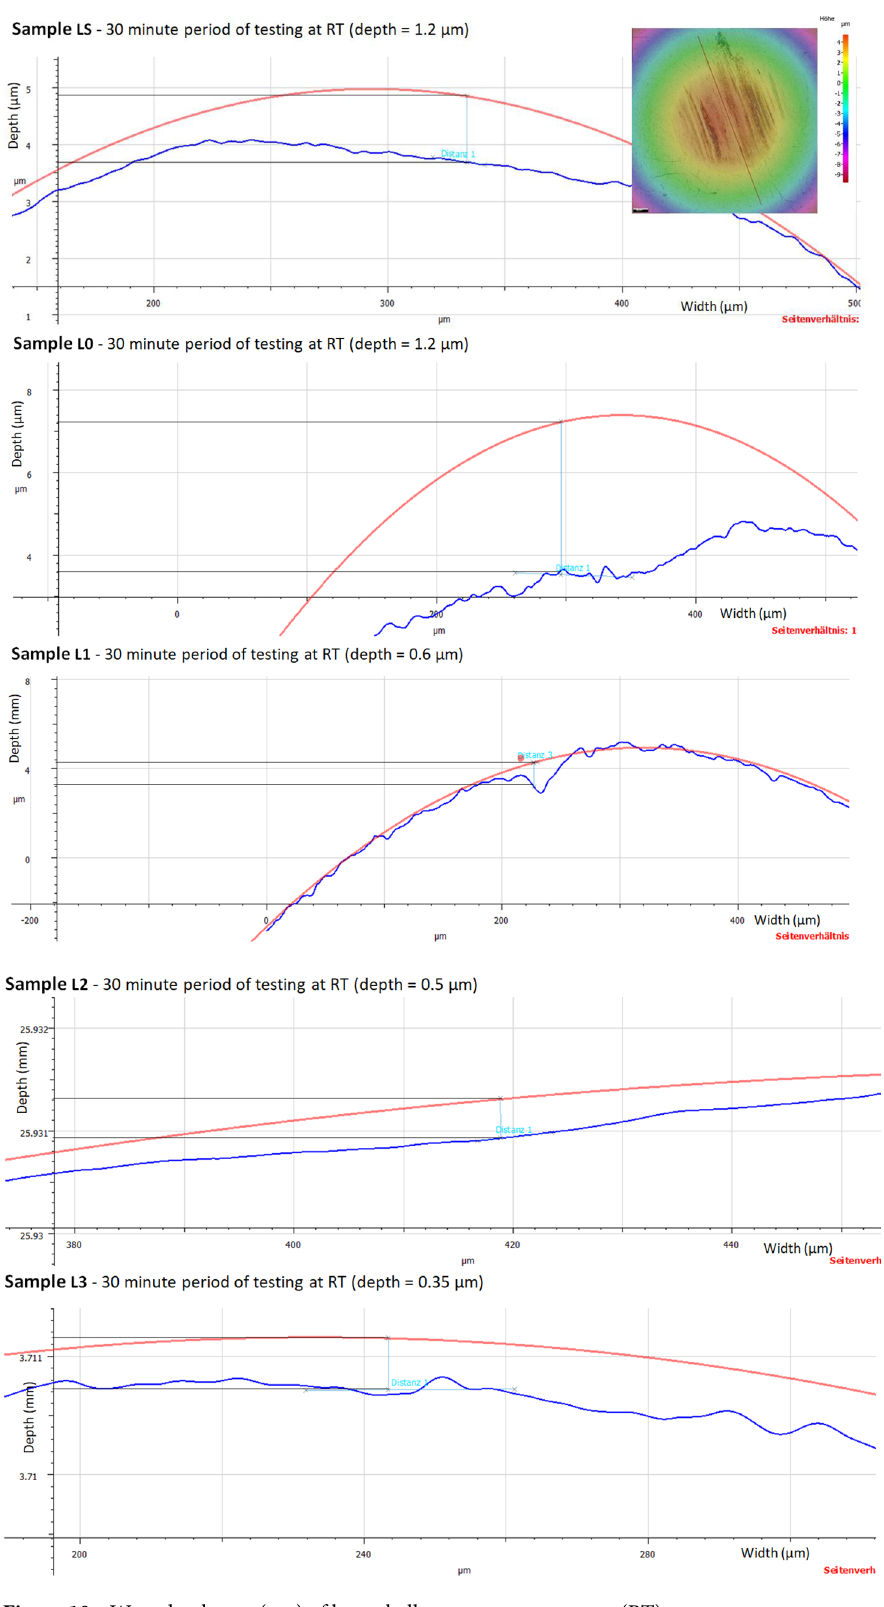
Figure 10. Wear depth scar (µm) of lower balls at room temperature